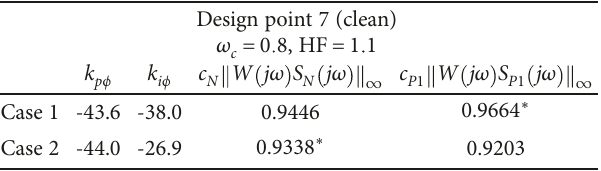
Table 4: Scaling factors for weighting functions. Table 5: The parameters of chosen W j ω for both case 1 and case 2 in Table 4, optimized CAS using our method, and H ∞ norms at c design point 7 ( ∗ indicates the model which has worse N